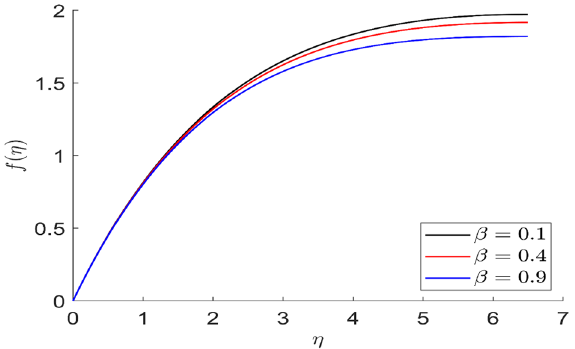
Figure 2. Representation of axial velocity f (η) for the different values of β with R = 3, n = 3, v = 0.3, φ = 0.3, Pr = 0.6, φ 1 = 0.1, φ 2 = 0.8, m = 1.5, β 1 = 0.2, β 2 = 0.5, β 3 = 0.5, u = 0.2, ξ = 0.2.